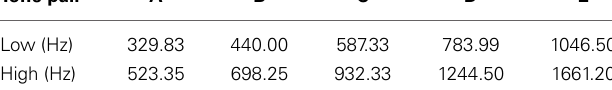
Non-Roving conditions. The Roving condition (top panel) depicts the five frequency levels (A–E, see Methods for further details) randomly distributed across trains within a stimulus block. The ST distance was 8-ST for all five frequency levels. In the Non-Roving condition (bottom panel), only one frequency level was presented throughout each stimulus block (here represented by Train C). Frequency levels were randomized across stimulus blocks (not trains). All five frequency levels (A–E) were used in both conditions. The vertical axis represents frequency (Hz) and the horizontal axis represents time (in seconds). Train duration was 2.48s. Intertrain interval (ITI) was 3.75s of